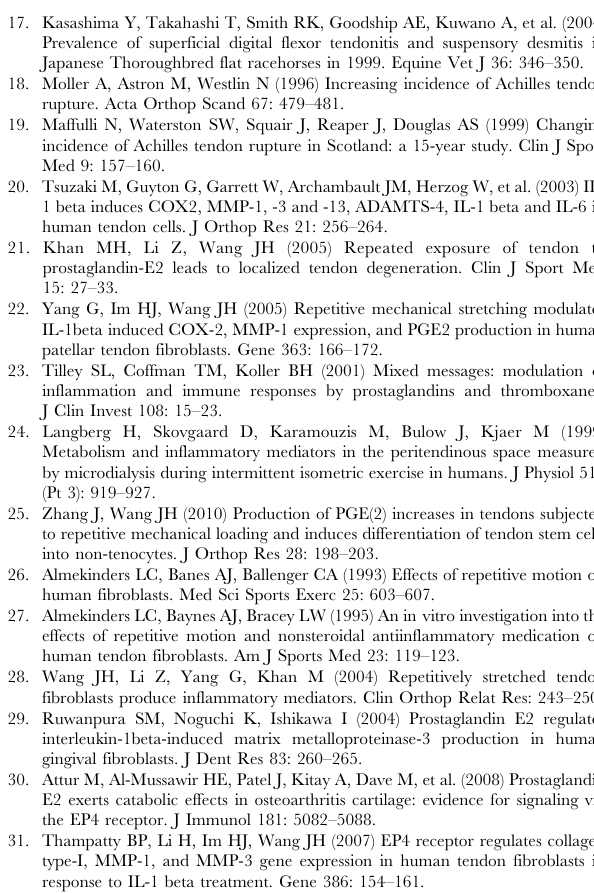
Figure S1 Prostaglandin E 2 (PGE 2 ) production by ten- don derived cells stimulated with IL-1 b (5 ngml -1 ) in vitro . Tendon cells derived from 8 year old horses (n= 3) had a reduced response to IL-1 b induced PGE 2 production compared to 3 year old horses (n= 3). Median values are shown with maximum and minimum